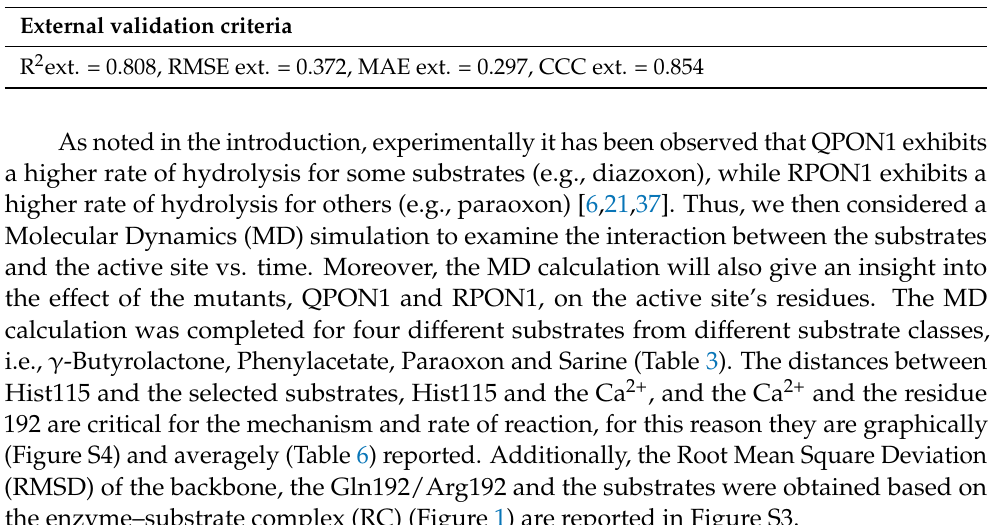
Figure 5. The distance between Glu192/Arg192 and Ca 2+ in the γ -Butyrolactone complexes after 20 ns. ( A ) QPON1. ( B ) RPON1.